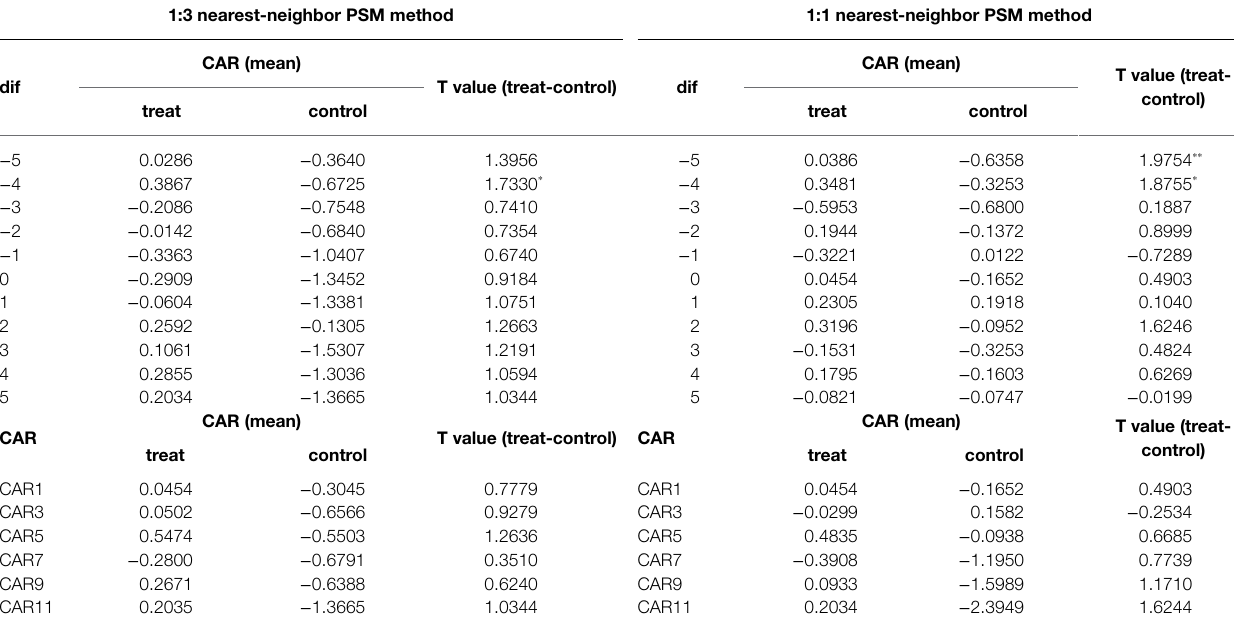
TABLE 3 | Non-green bonds in Mainland China.